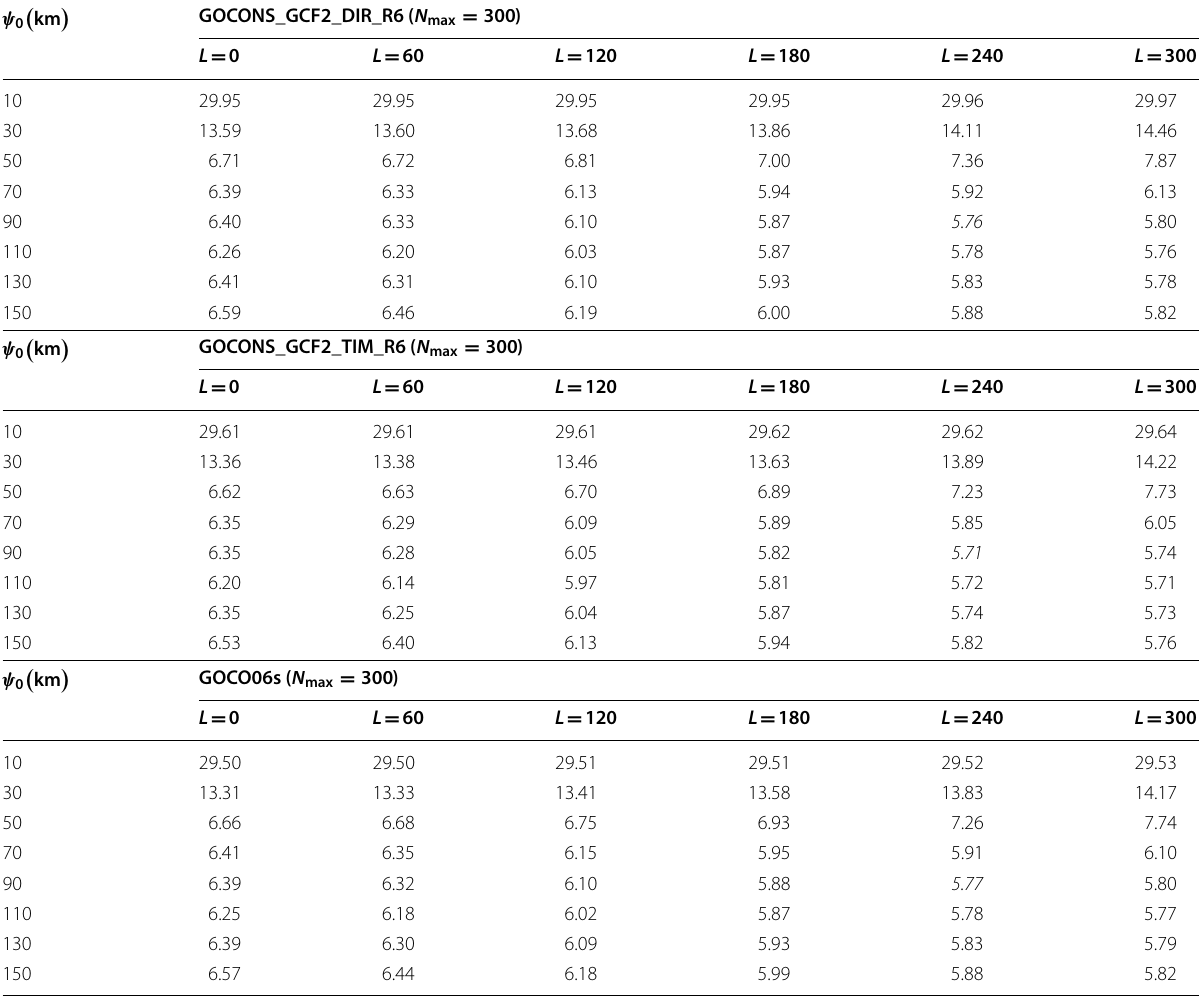
The modification parameters of Stokes’ integral kernel (the integration radius ψ 0 and the degree of Molodensky modification L ) used in the computation are also shown Italics indicates minimum value of SD in each